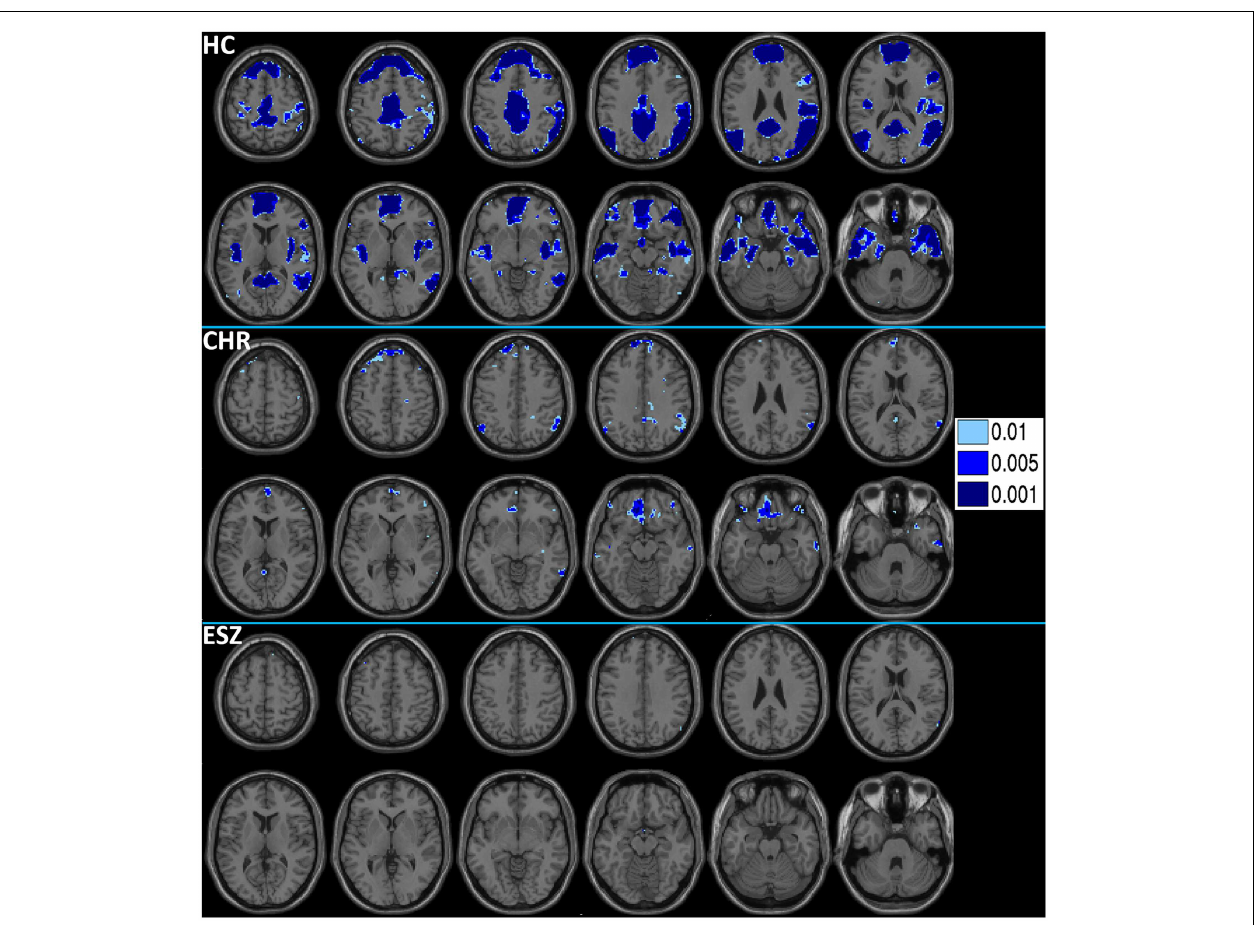
thresholds ( p < 0.01, p < 0.005, and p < 0.001), and include default mode network (DMN) nodes such as the medial prefrontal cortex, posterior cingulate cortex, and right and left lateral posterior parietal cortices in HC participants. Extent of axial montage is 58mm > Z > − 30mm, with a 8-mm